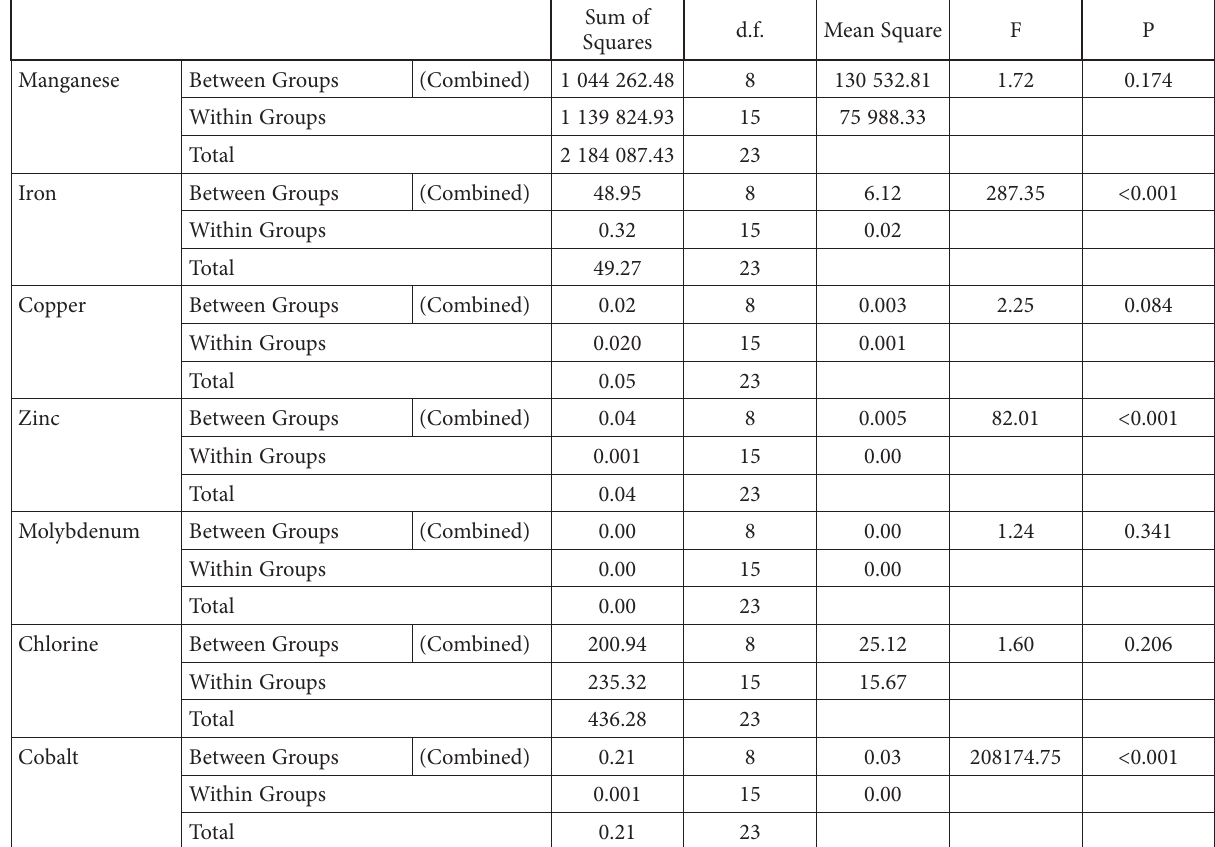
Table 10. ANOVA of the micro-nutrient